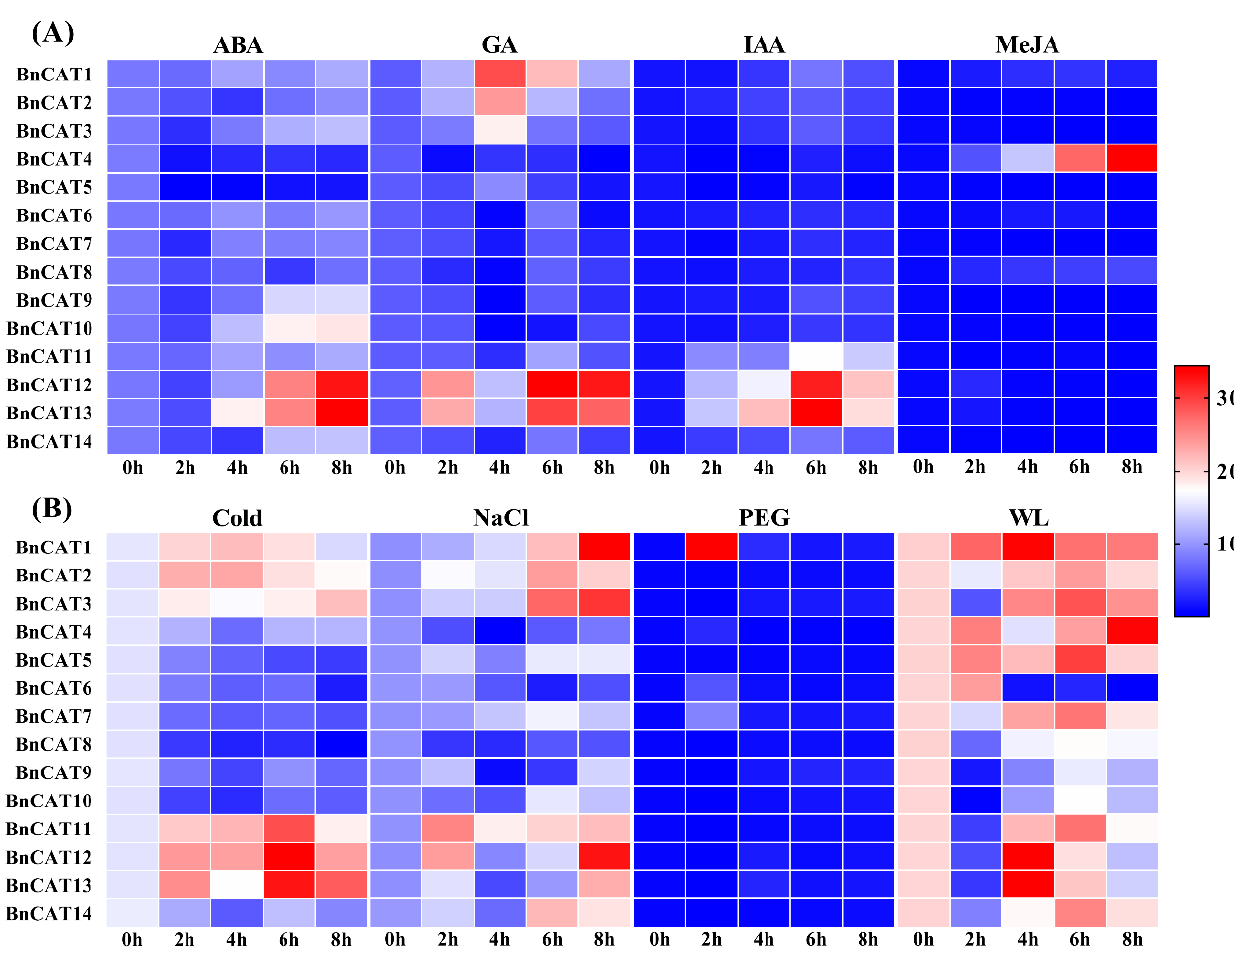
Figure 8. Expression patterns of the BnCAT genes under various hormones and abiotic stress. ( A ) Expression profiling during hormone treatments, including abscisic acid (ABA), gibberellic acid (GA), indole-acetic acid/auxin (IAA), and methyl jasmonate (MeJA). ( B ) Expression profiling under abiotic stresses, including cold, salinity (NaCl), drought (PEG-6000), and waterlogging (WL). The 0h (CK), 2h, 4h, 6h, and 8h labels displayed the time points (hours) when the samples were harvested for expression analysis after the stress treatment. The bars show the comparative gene expression patterns examined via the 2 − ΔΔ C T method. The red color shows high, and the blue color shows low expression levels.